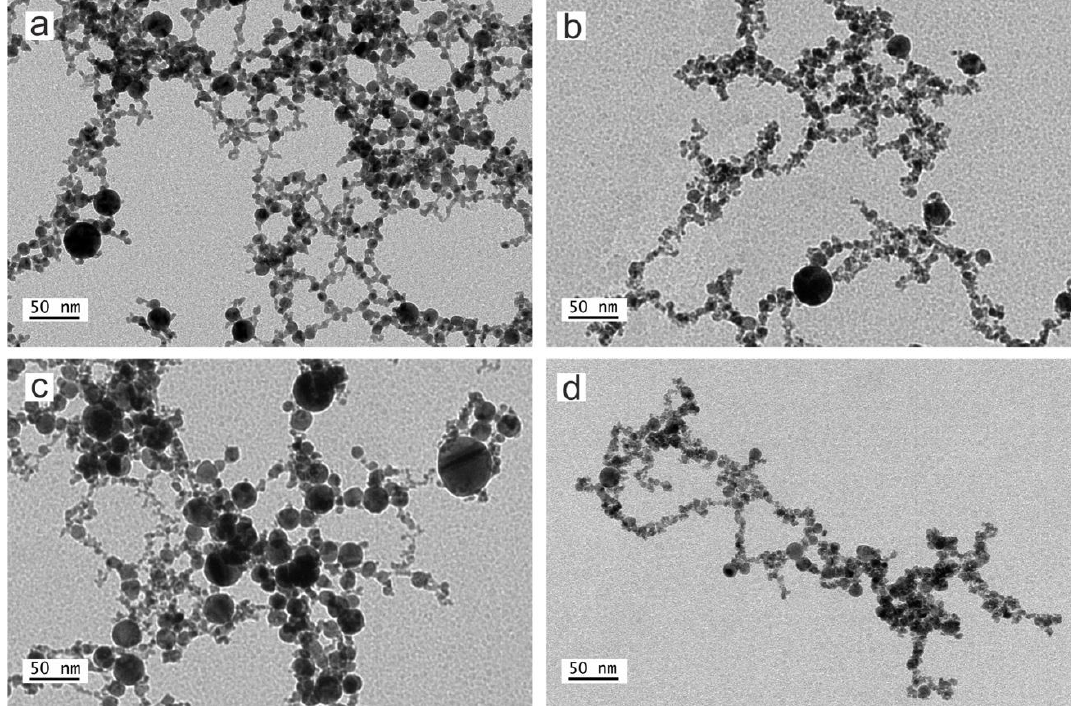
Figure 2. TEM micrographs of Pd nanoparticles synthesized by laser ablation with ( a ) 532 nm of wavelength in water, ( b ) 532 nm in methanol, ( c ) 1064 nm in water and ( d ) 1064 nm in methanol.